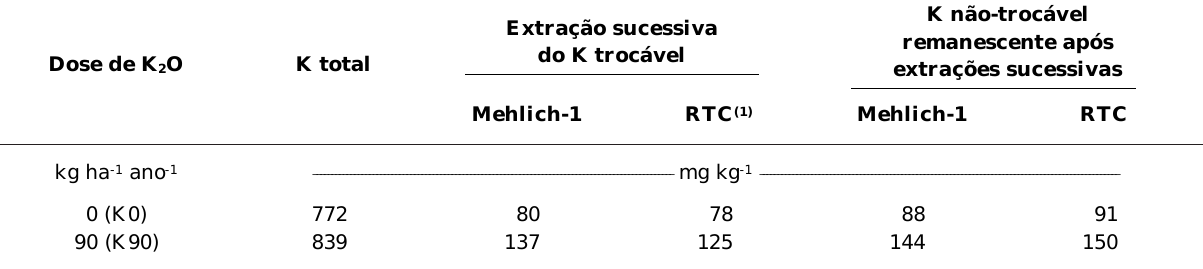
Quadro 2. Teores de potássio total, trocável acumulado por sucessivas extrações e não-trocável remanescente após as extrações sucessivas em amostras de solo (0–10 cm) que não receberam (K0) e que receberam potássio (K90) via fertilização durante onze